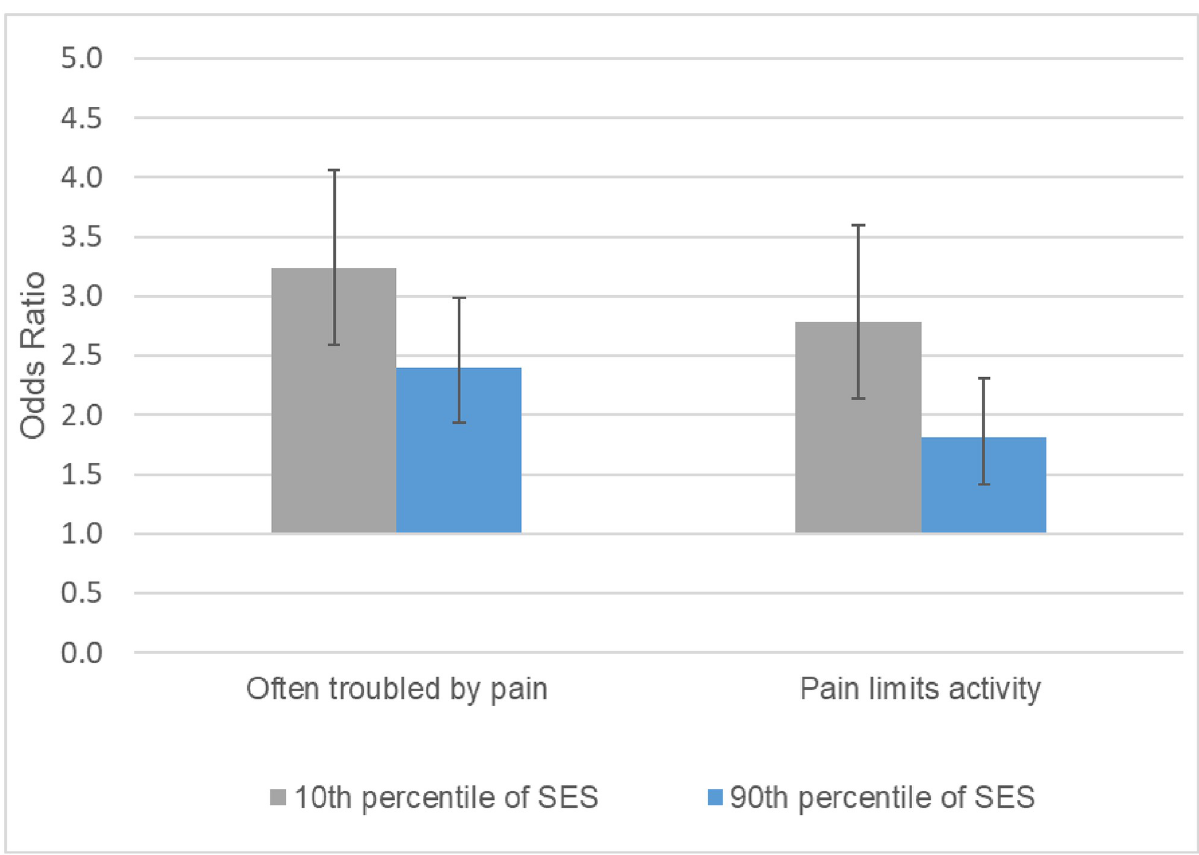
Fig 4. Period change in overall pain at age 50 for 10 th vs. 90 th percentile of SES, HRS 1996–2016. These results are based on the models shown in Table G in S1